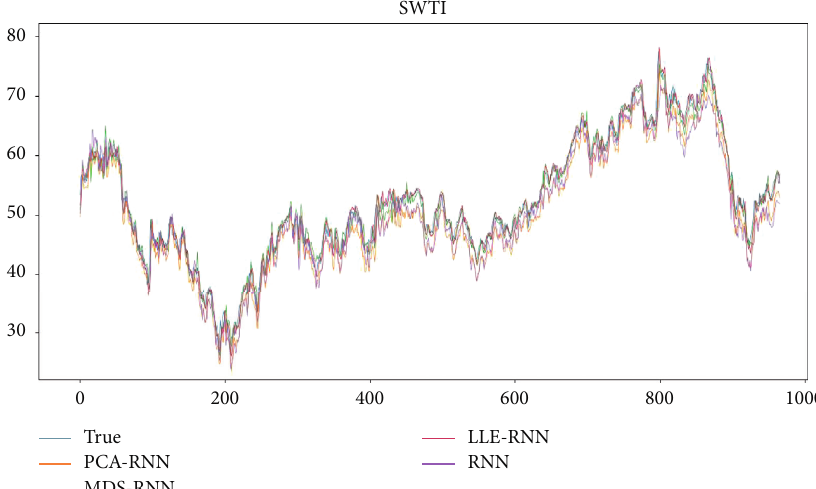
Figure 11: Prediction results of crude oil spot prices by the RNN benchmark